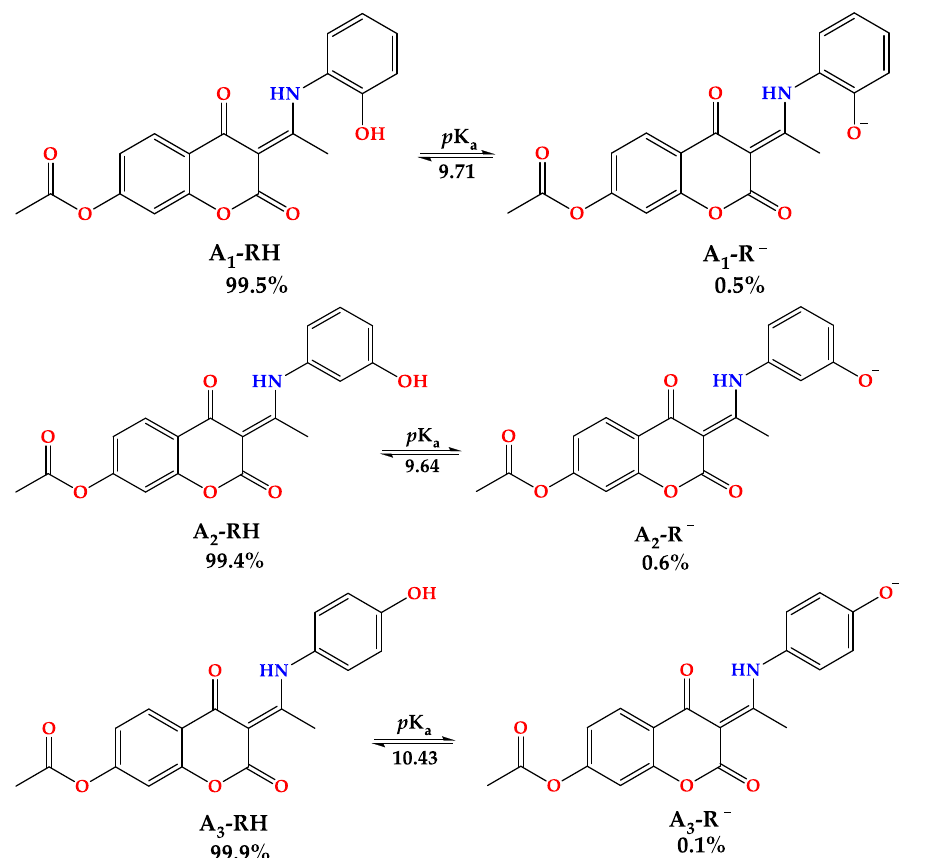
Figure 4. Deprotonation process, estimated p K a values, and molar fractions ( f ) of acid–base species of newly synthesized aminophenol derivatives of 4,7 − dihydroxycoumarin (A 1 RH to A 3 RH) at physiological pH = 7.4.